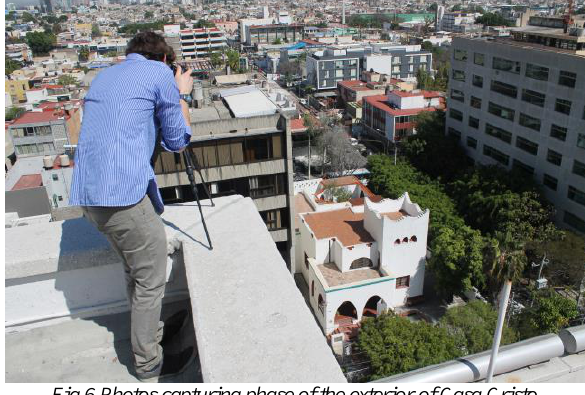
Fig.6 Photos capturing phase of the exterior of Casa Cristo. Photo’s author: Kathleen Chin.